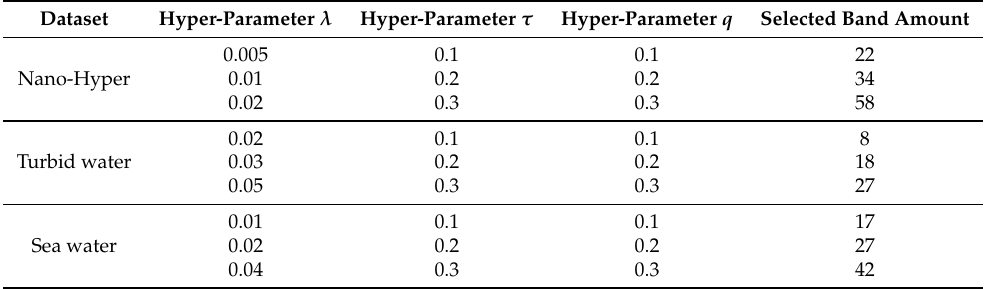
Table 2. The hyper-parameter settings and their corresponding selected band amounts for different datasets. Dataset Hyper-Parameter λ Hyper-Parameter